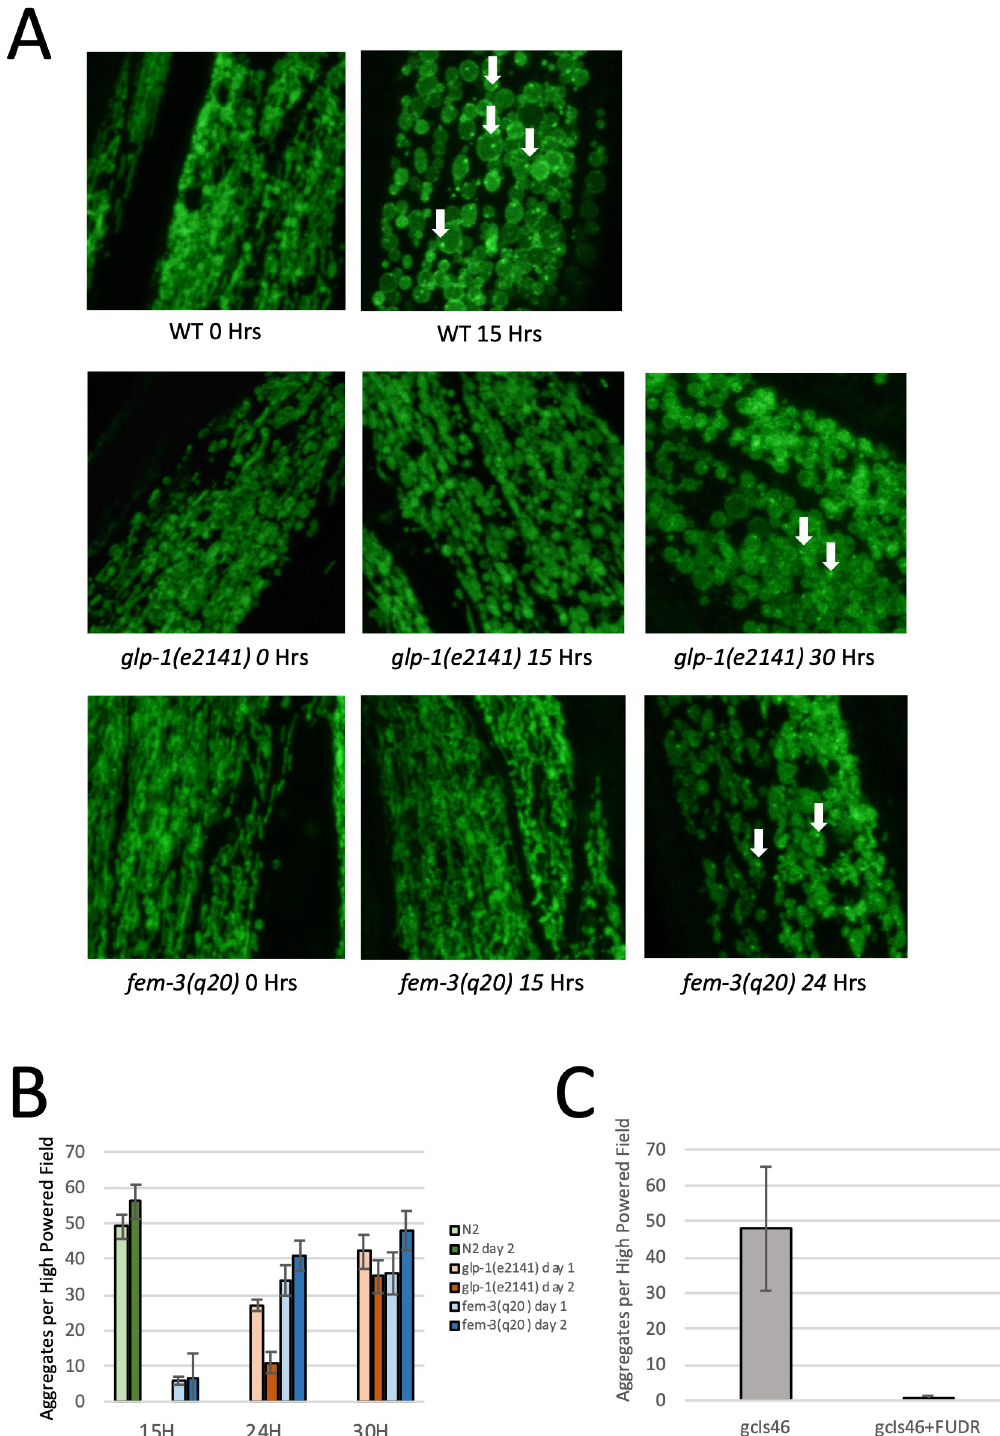
Fig 3. Sterile Mutations Prevent Hypoxia Dependent Mitochondrial Protein Aggregation. (A) GFP fluorescence images of WT, glp-1(e2141) and fem-3(q20) day 1 adults. Fluorescence is from a GFP tagged UCR-11 protein which localizes to body wall muscle mitochondria. The identity of the strain background being shown, along with the time of hypoxia exposure is written below each image. Examples of mitochondrial protein aggregates are indicated by the white arrows. 15 hours of hypoxia is sufficient to cause rounding of the mitochondria and significant mitochondrial protein aggregation in WT worms,